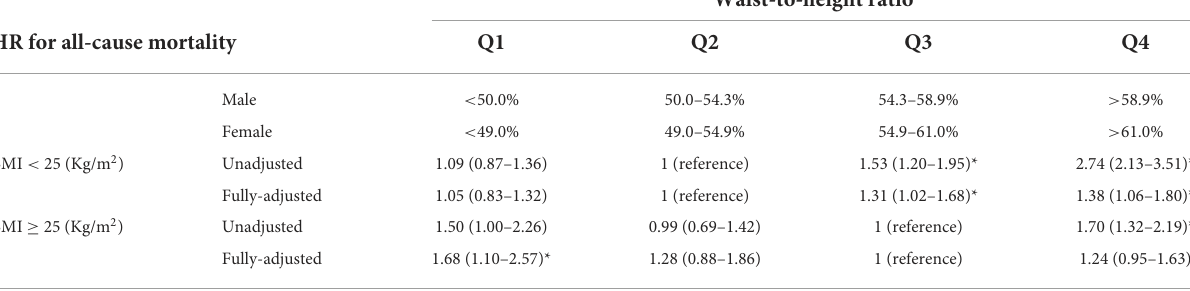
Waist-to-height